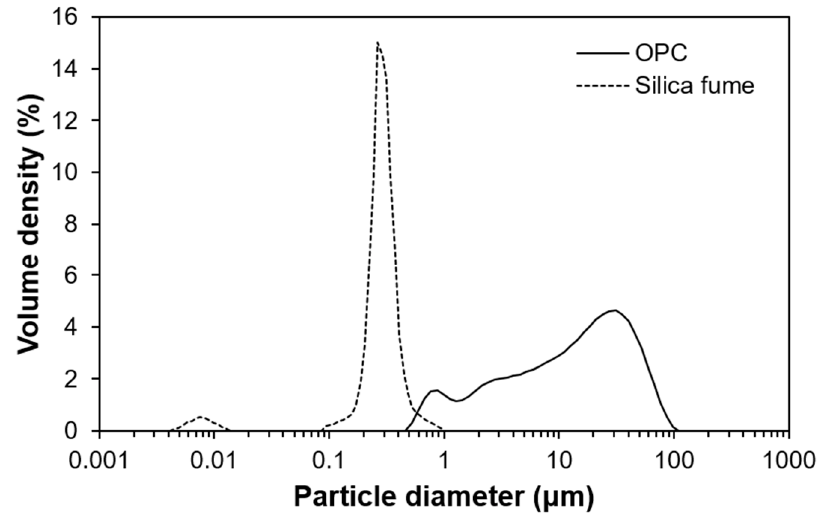
Figure 1. Particle size distributions of ordinary Portland cement and silica fume .